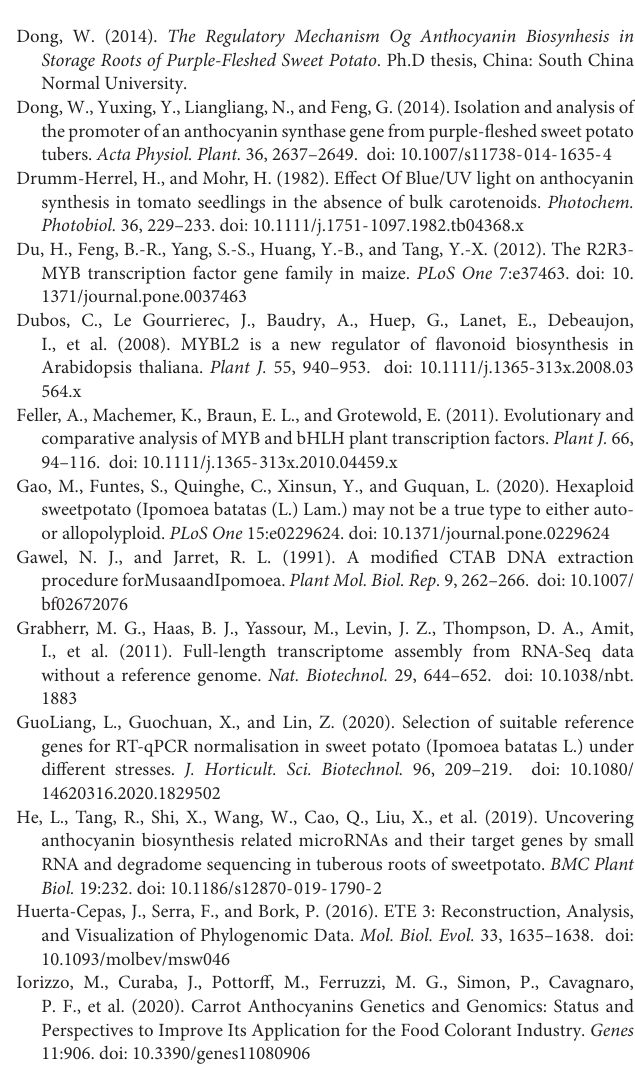
RNA-Seq reads around IbMYB2-4 locus in reference genome sequence (Taizhong No.6). (C) Alignment of RNA-Seq reads around IbMYB2-1 locus in reference genome sequence (Taizhong No.6). (D) Coding sequence and amino acid sequence alignment among IbMYB1 , IbMYB2s-a , and IbMYB2s-b gene members. Supplementary Figure 10 | InDels of 5 (cid:48) flanking sequence of IbMYB2s gene. IbMYB2s is the 5 (cid:48) flanking sequence that cloned from the genome in this study; IbMYB2-1 and IbMYB2-1 are the 5 (cid:48) flanking sequences that obtained from the reference genome sequence. Supplementary Figure 11 | InDels of 3 (cid:48) flanking sequence of IbMYB2s gene. 3 (cid:48) UTR1–3 (cid:48) UTR5 were the 3 (cid:48) flanking sequences of IbMYB2s that cloned from the genome in this study; IbMYB2-1 and IbMYB2-4 were the sequences that reported in references. Supplementary Table 1 | List of all primers for PCR. Supplementary Table 2 | The amino acid sequence of the anthocyanin/flavonoid-related genes from the transcriptome data. Supplementary Table 3 | The amino acid sequence for the evolutionary tree of MYBs from Ipomoea batatas , Ipomoea nil , Ipomoea triloba , Ipomoea trifida , and Arabidopsis thaliana